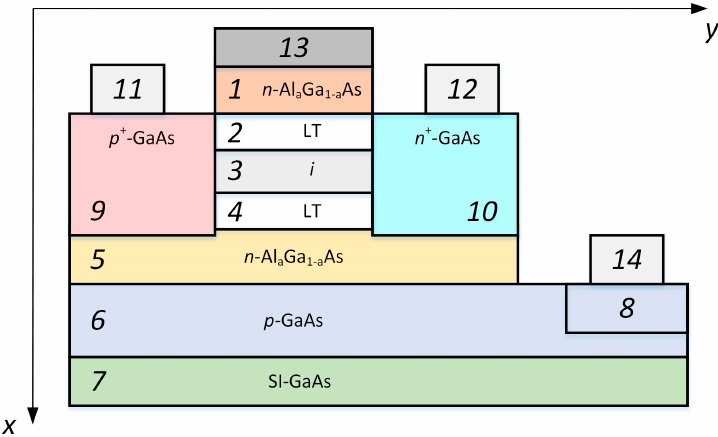
Figure 1. Cross-section of the photodetector with controlled relocation of carrier density peaks: 1, n -Al a Ga 1 − a As region of upper Schottky control junction; 2, upper LT-In 1 − b Ga b As layer; 3, i -In 1 − c Ga c As d Sb 1 − d absorbing region; 4, lower LT-GaAs 1 − e Sb e layer; 5, n -Al a Ga 1 − a As region of lower control p - n junction; 6, p -GaAs region of lower control p - n junction; 7, semi-insulating GaAs substrate; 8, p + -GaAs heavily doped near-contact subregion; 9, 10, p + -GaAs and n + -GaAs heavily doped regions; 11, 12, supply contacts; 13, 14, control contacts.